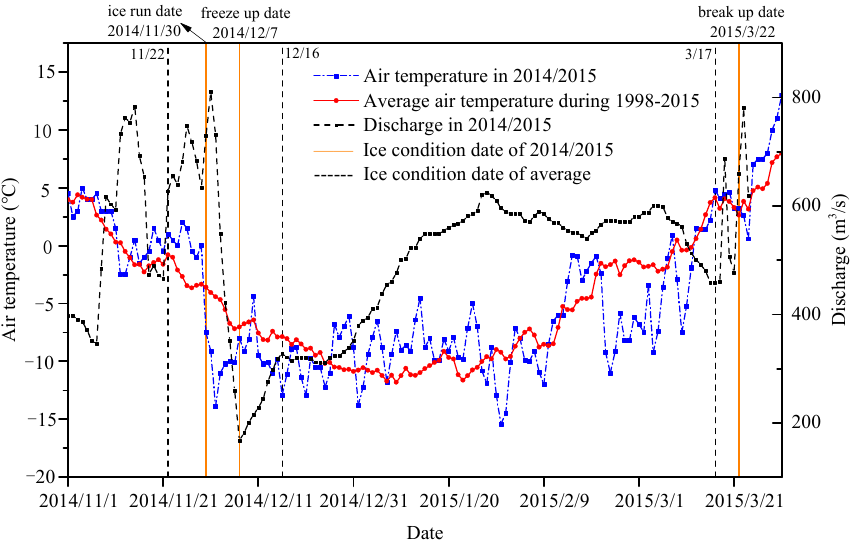
Figure 9. Comparison of the average daily temperature in 2014–15 to the past 17